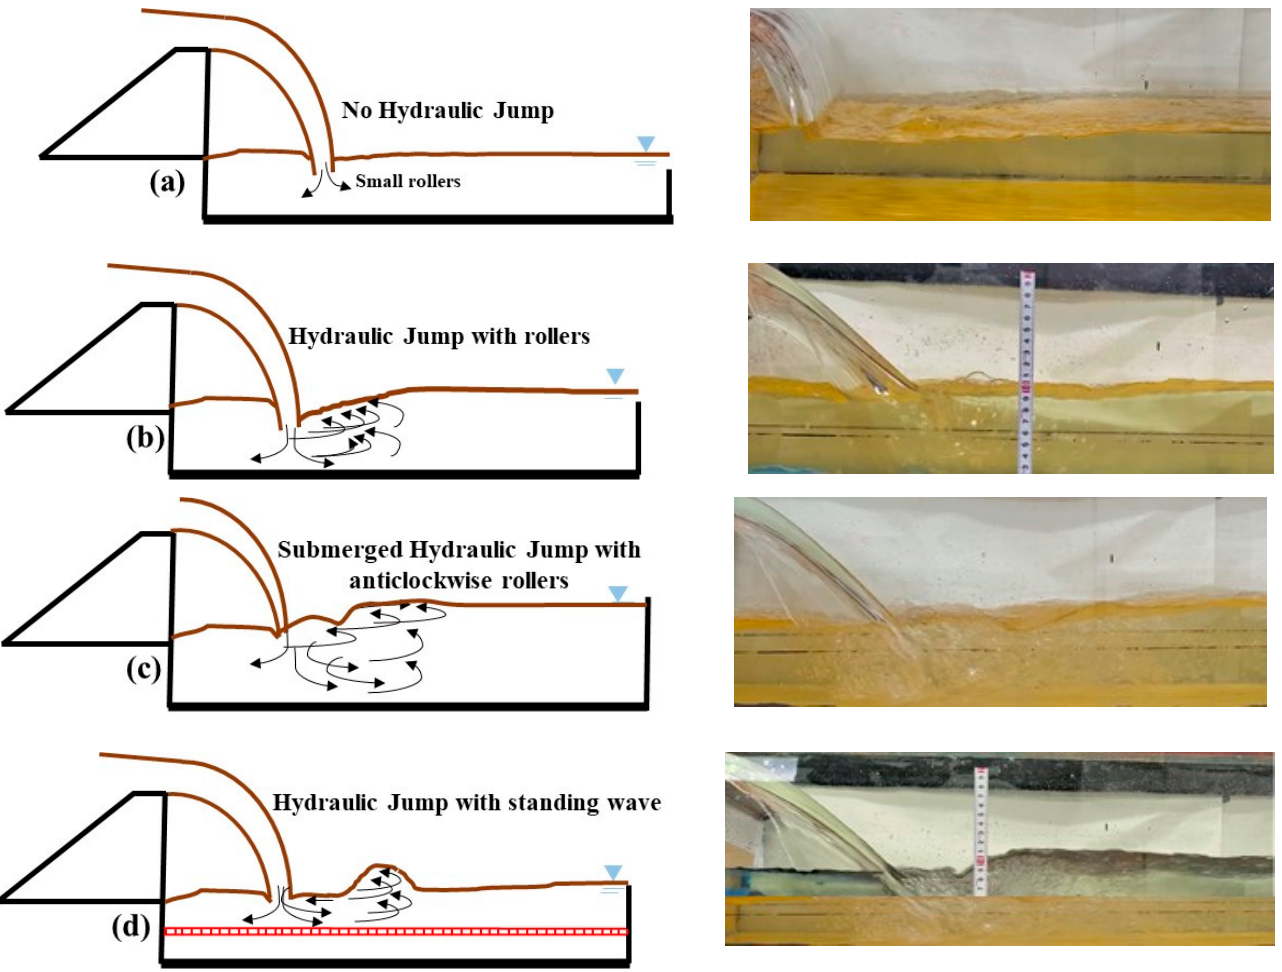
Figure 4. Manifestation of observed flow structure. ( a ) Type ( a ); ( b ) type ( b ); ( c ) type ( c ); ( d ) type ( d